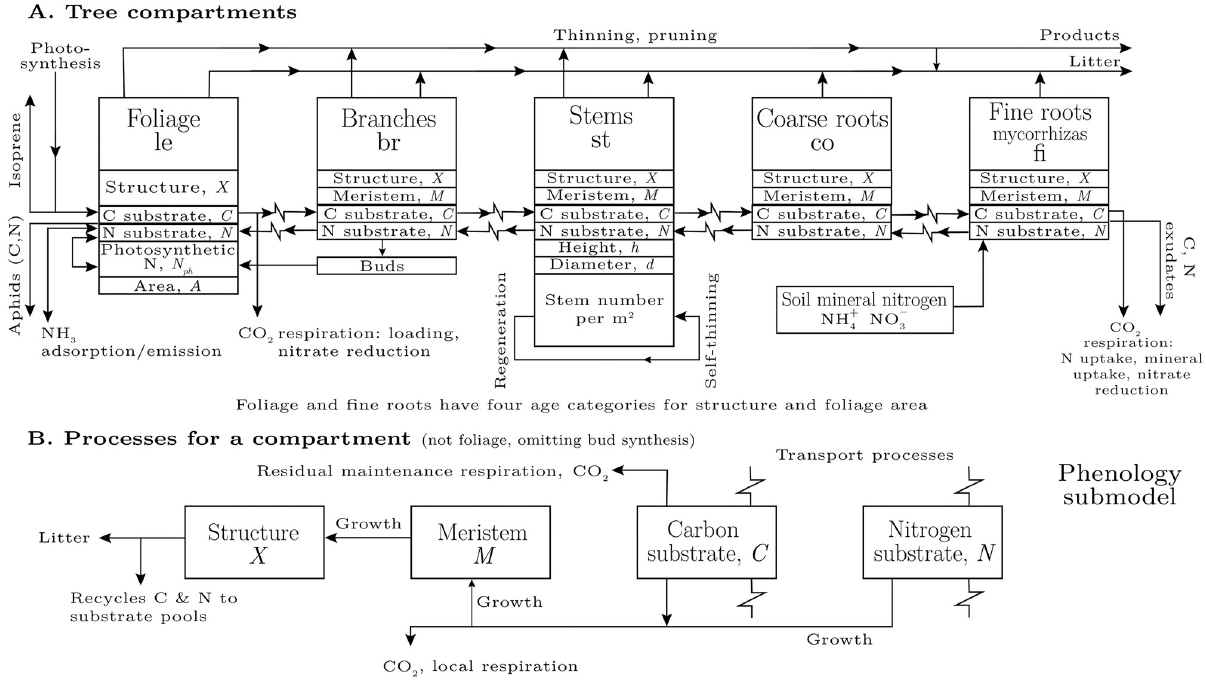
Fig 1. Tree sub-model of the Edinburgh Forest Model (efm). Aphids are connected to the tree sub-model on the left side in A, where aphids extract C and N from the foliage (leaf, le) substrate pools, denoted C le and N le , via the phloem [Eq (2)]. The aphid sub-model can be ‘switched off’ entirely (the default